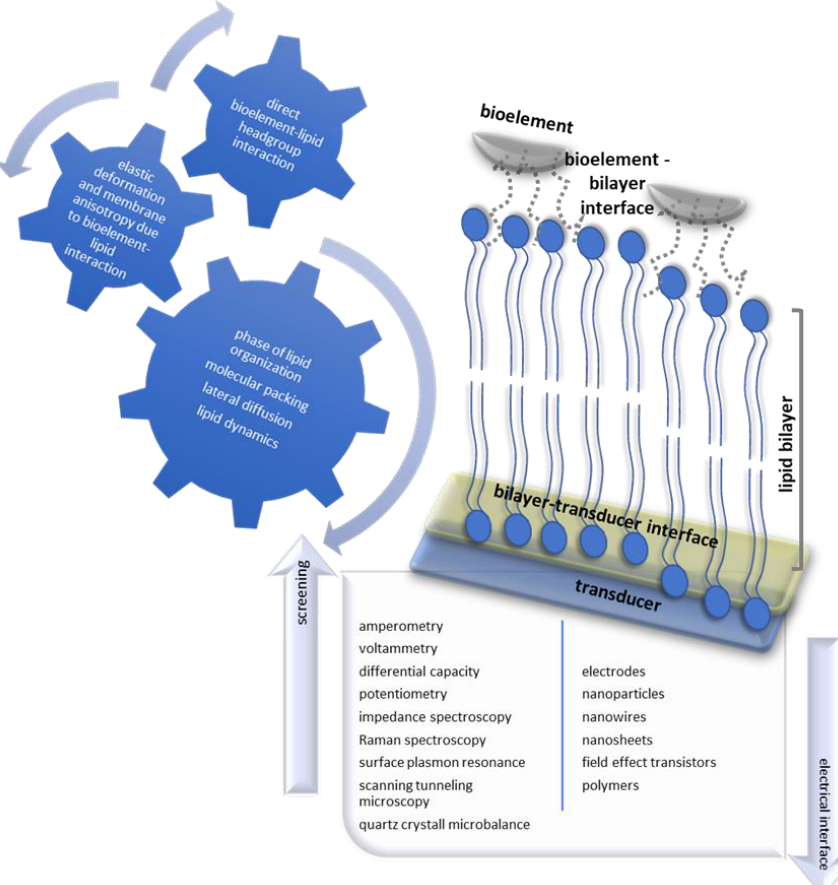
Figure 1. Simplified overview of the basic lipid membrane platform for biosensor development, illustrating, also, the critical physical chemistry that gears the biochemical information produced on the membrane surface for electrochemical transduction and the most common screening strategies